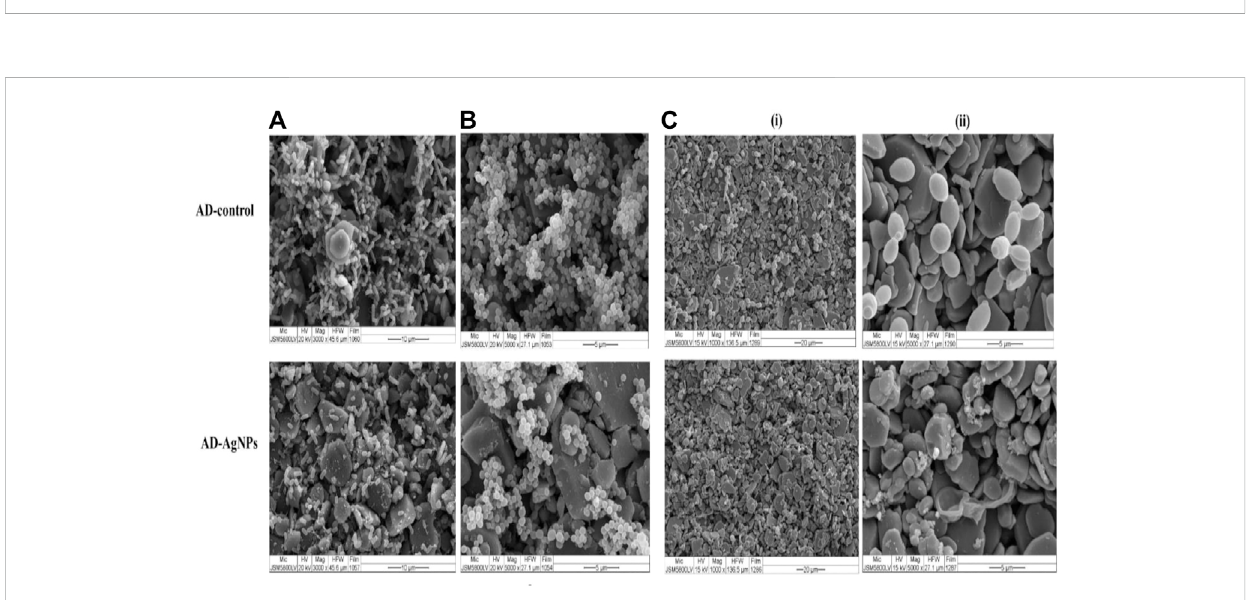
FIGURE 10 Scan electron microscopy image of bio fi lm formation of MNPs modi fi ed and control ceramic against E. coli (A) , S. aureus (B) , C. albicans (C) . MicrobialadhesiontoMNPsmodi fi edandcontrolceramicsafter4 h.ReproducedwithpermissionfromNwaboretal.(2021a).Copyright2021,Taylorand